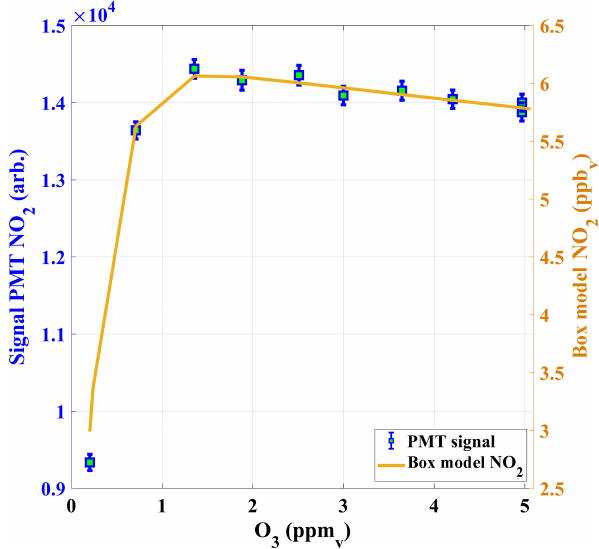
Figure 4. The PMT NO 2 signals in counts (cts) are shown as a function of O 3 concentrations in the calibrator (left y axis), together with NO 2 calculated from a box model of the NO 2 production in the calibrator (right y